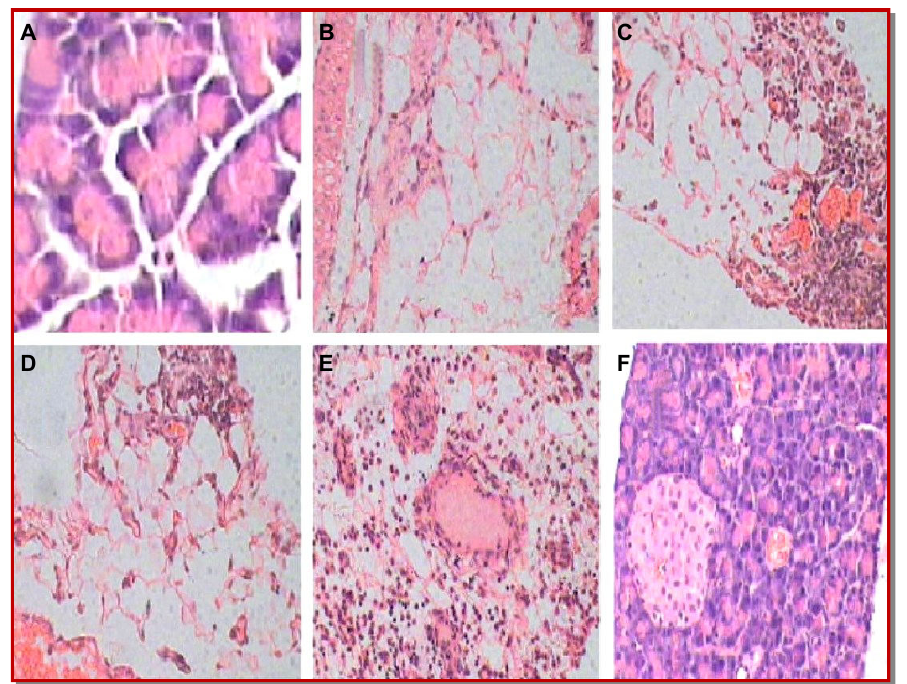
Figure 1: (A) Normal pancreas showing no pathological changes with normal islets of Langerhans; (B) Pancreas (diabetic control) showing diffused necrotic changes of moderate to marked degree as a result of which they were significantly reduced in size and number; (C) Pancreas treated with glibenclamide 10 mg/kg), after 22 days: Showing improvement and minimal degenerative changes; (D) Pancreas treated with Bombax ceiba ethyl acetate extract 200 mg/kg), after 22 days: Not showing improvement or restoration of normal cellular size of islets; (E) Pancreas treated with Bombax ceiba ethyl acetate extract 400 mg/kg), after 22 days: showing less improvement with nearly normal islets of Langerhans; (F) Pancreas treated with Bombax ceiba ethyl acetate extract 600 mg/kg), after 22 days: Showing marked improvement with nearly normal islets of